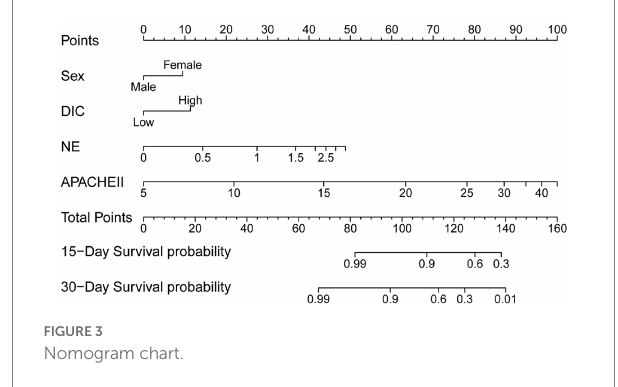
FIGURE 2 Nonlinear trend.